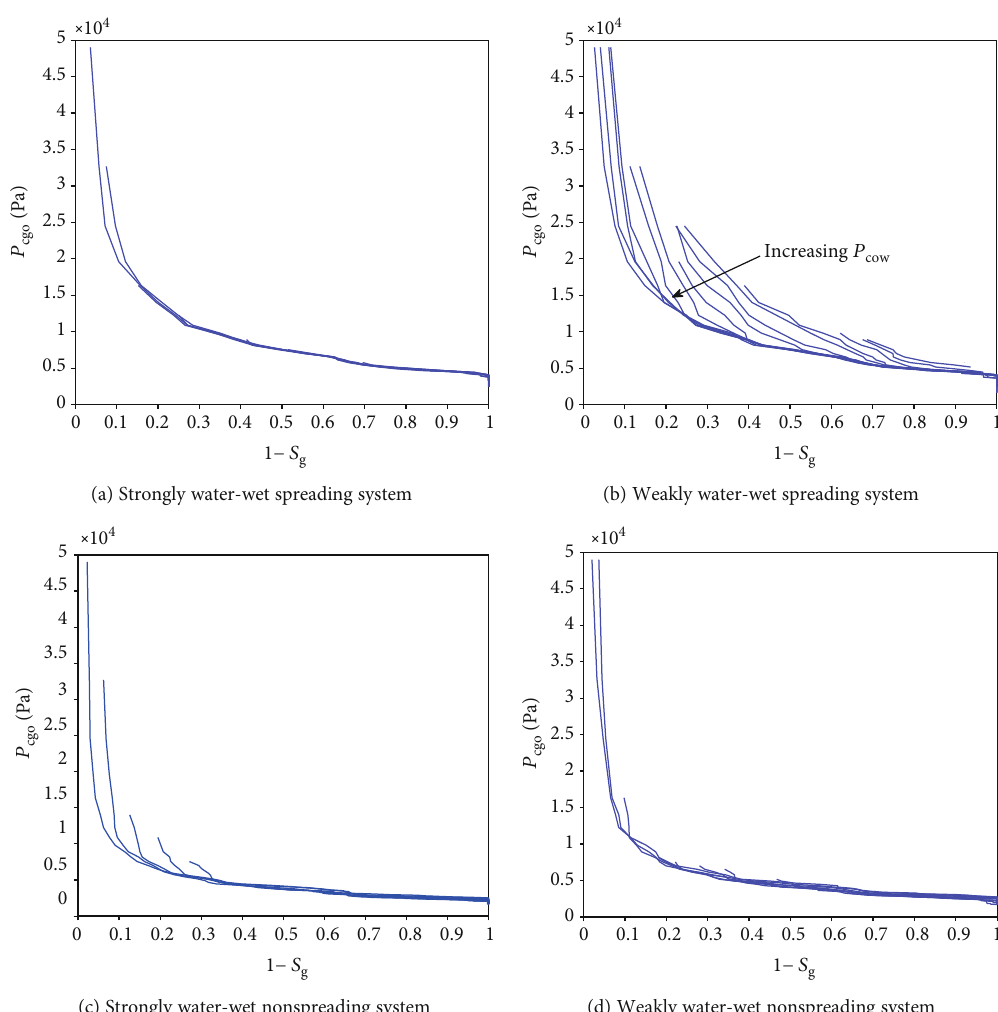
Figure 14: Three-phase gas-oil capillary pressure curves as a function of total liquid saturation for several constant oil-water capillary